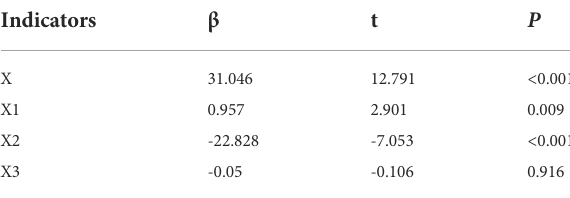
TABLE4Impactoftheimplementationoftheexpertconsensusonthe prevalence of PIM